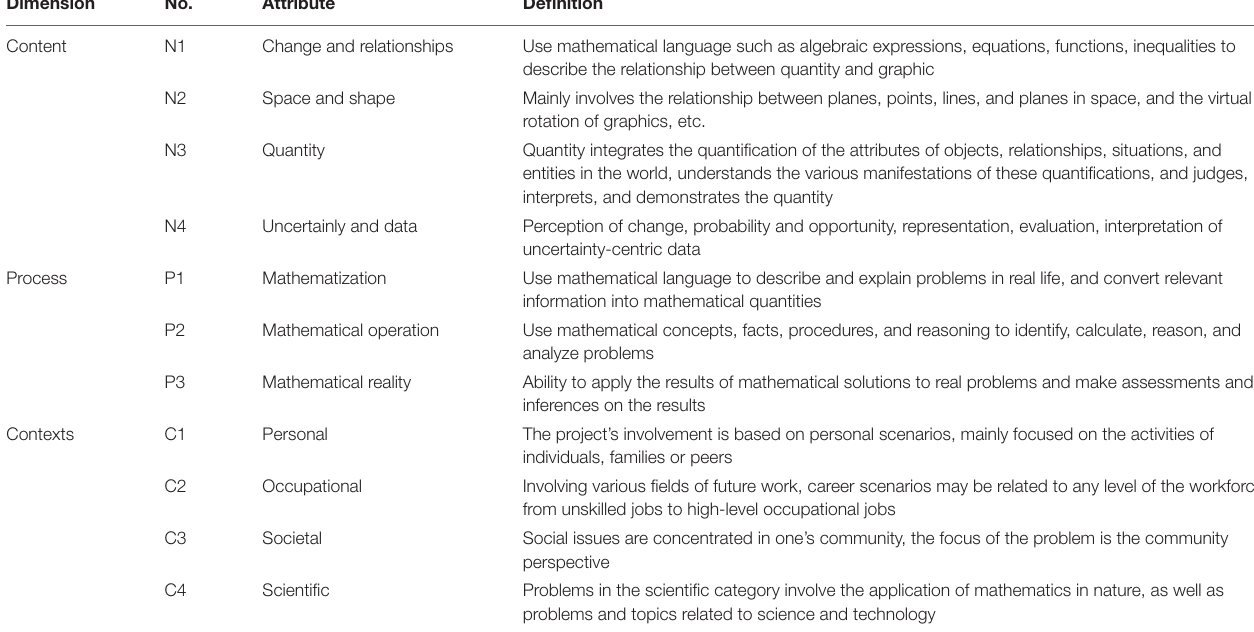
TABLE 1 | Dimensions of PISA’s cognitive attributes. Dimension